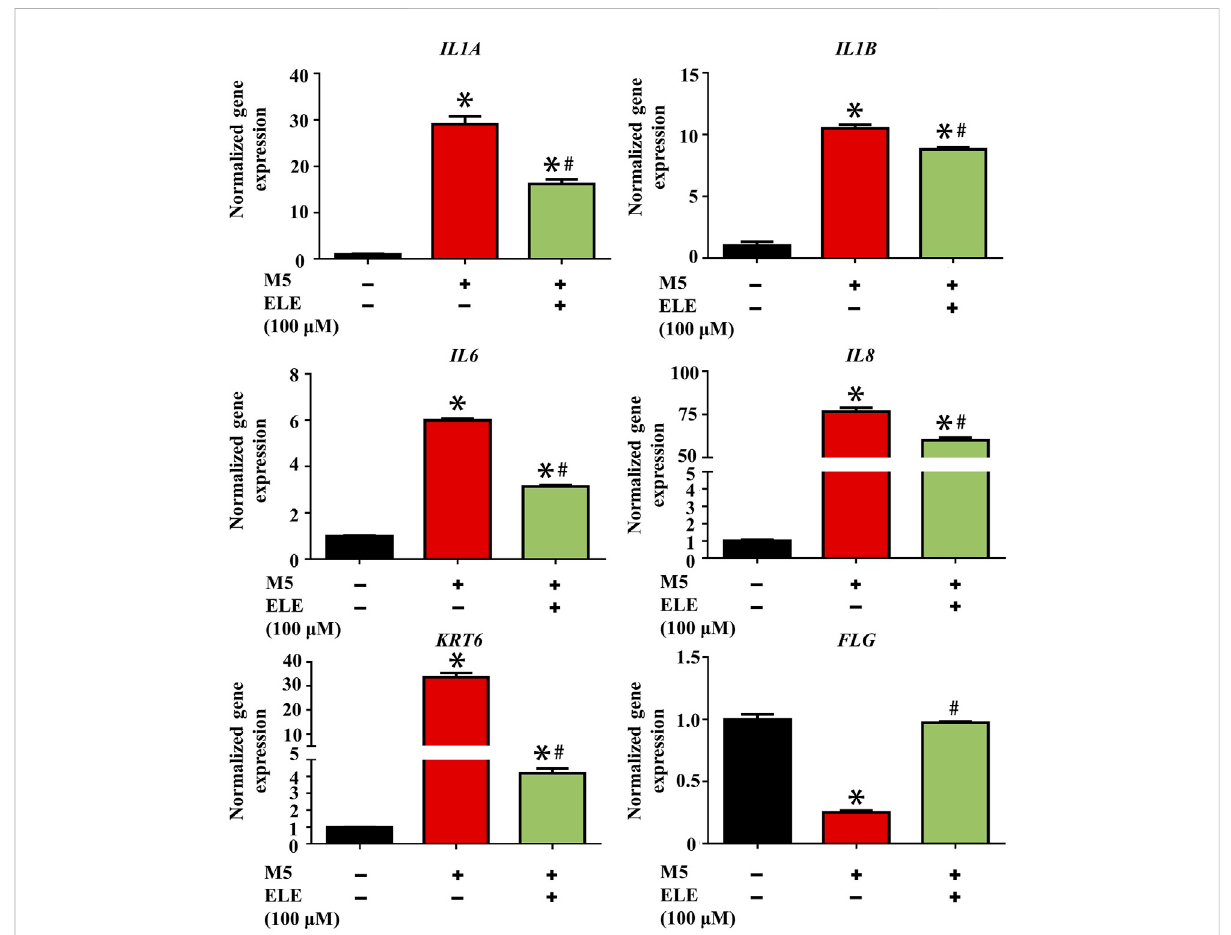
of key in fl ammatory cytokines in M1-Mø. As shown in Figure 3A, ELE signi fi cantly down-regulated the expression of Tnf (encoding TNF- α ), Il1a (encoding IL-1 α ), and Il12a (encoding IL-12A) in M1-Mø. In addition, we also investigated how the ELE-pretreated M1-Mø indirectly affects keratinocytes (Figure 3B). As demonstrated in Figure 3C, CM collected from M1-Mø signi fi cantly enhanced the expression in keratinocytes, while the expression of these two genes was signi fi cantly down-regulated after exposure to the ELE- pretreated M1-Mø CM. Although no up-regulation of IL1B was detected in keratinocytes treated with M1-Mø CM, ELE- pretreated M1-Mø CM signi fi cantly reduced the expression of IL1B in keratinocytes. These data indicate that ELE indirectly in fl ammatory cytokines released from